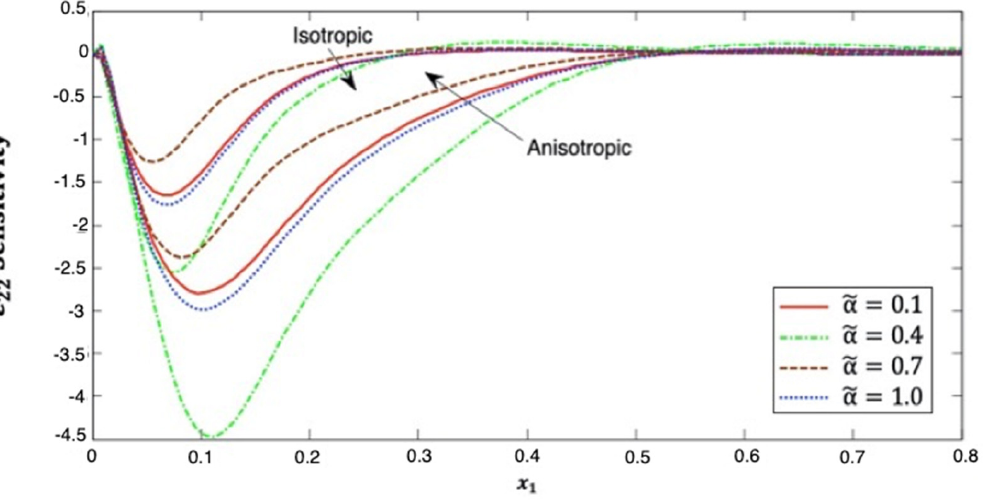
Figure 10. Distribution of the ε 22 sensitivity along x 1 –axis in isotropic and anisotropic FRP composites for various fractional-order values.